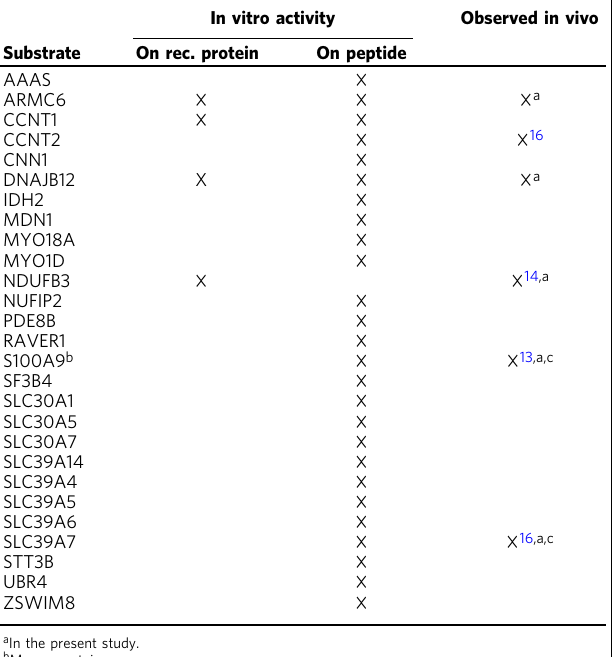
Table 1 Identi fi ed METTL9